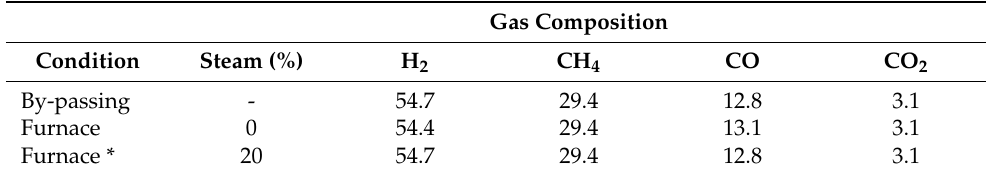
Table 8. Results of blank tests with the following gas composition variation considering the gas flow through the furnace at 600 ◦ C with and without steam. This assessment was performed without sorbent inside the quartz reactor and all results had a standard deviation inferior to 0.4%. Gas Composition Steam (%) H 2 CH 4 CO CO